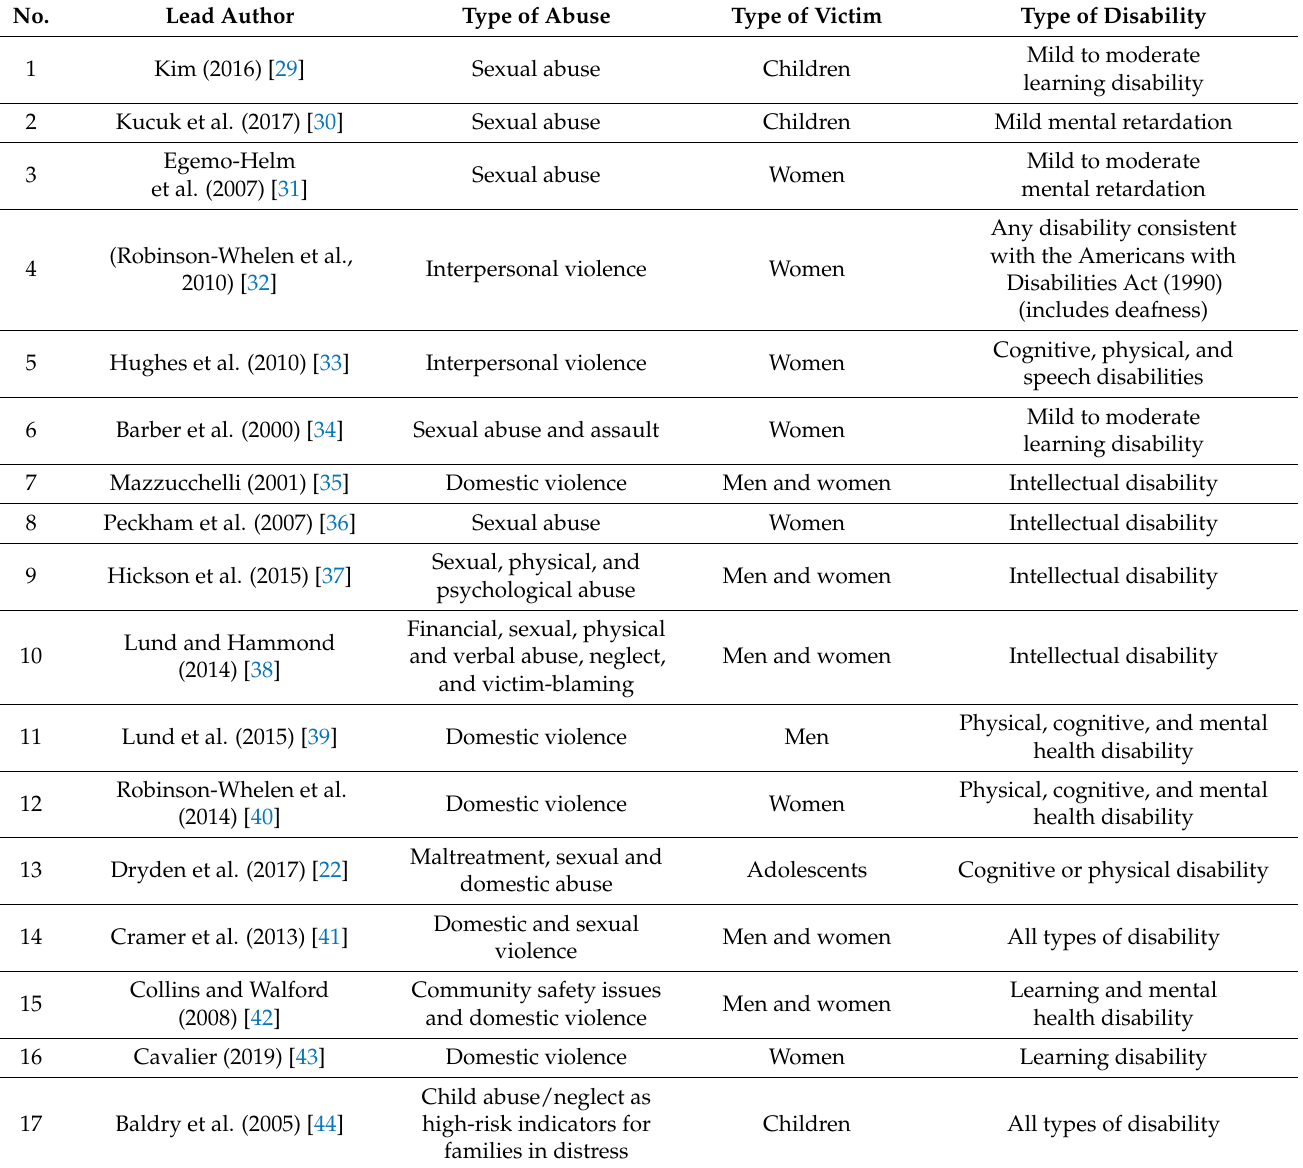
Table 2. Intervention